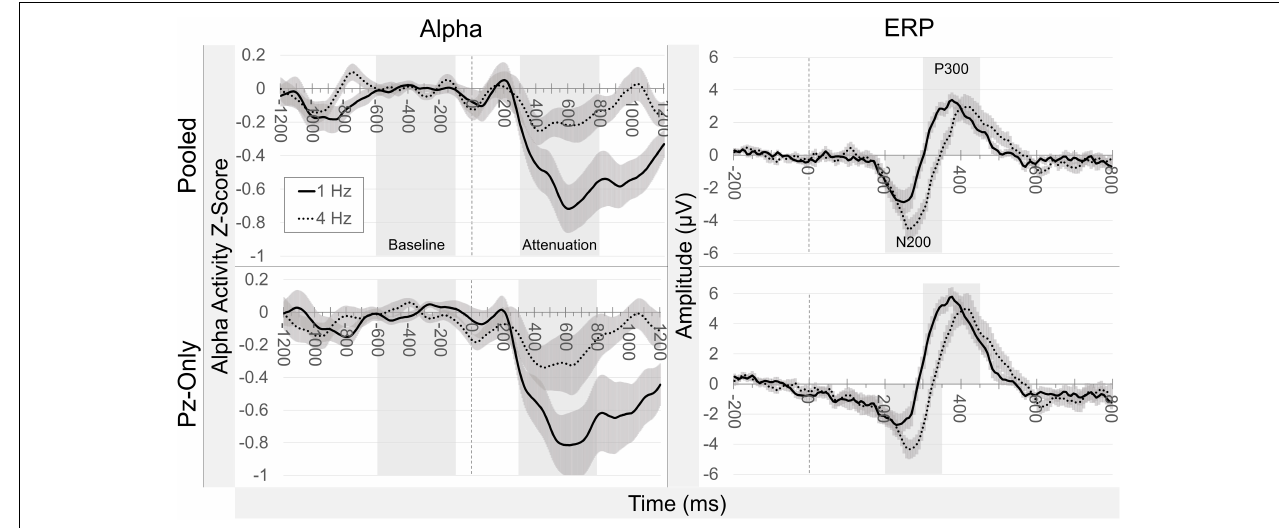
FIGURE 7 | Difference waveforms. Grand average difference waveforms illustrate target minus non-target signals. Alpha attenuation (column 1) and ERP target effects (column 2) are separated according to signal source and presentation rate condition. Highlighted temporal windows correspond to baselines and measured attenuation (alpha), and default peak detection settings (ERPs). There is a clear reduction in alpha attenuation in the 4 Hz condition, while N200 and P300 target effects remain relatively similar in magnitude between presentation